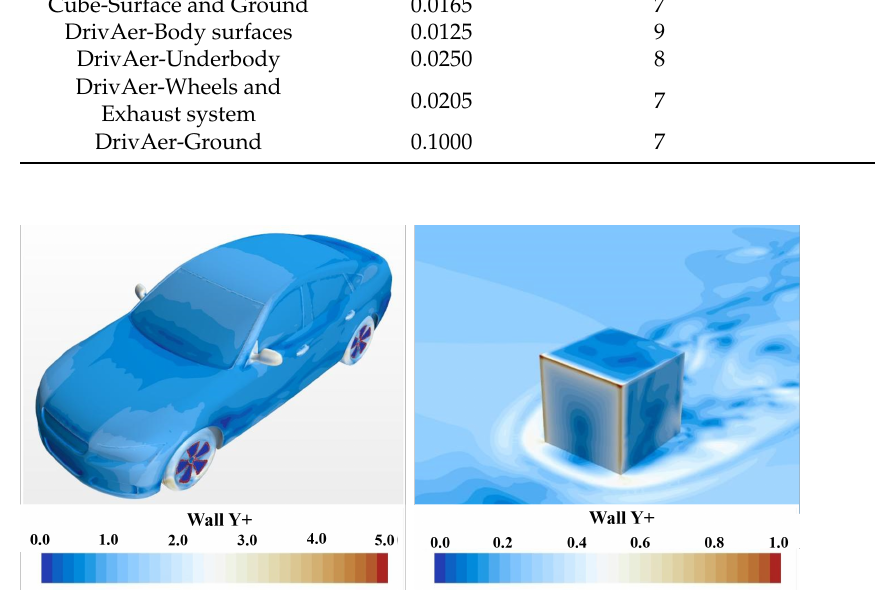
Figure 4. Scalar Scenes Showing the Value of y + for Each